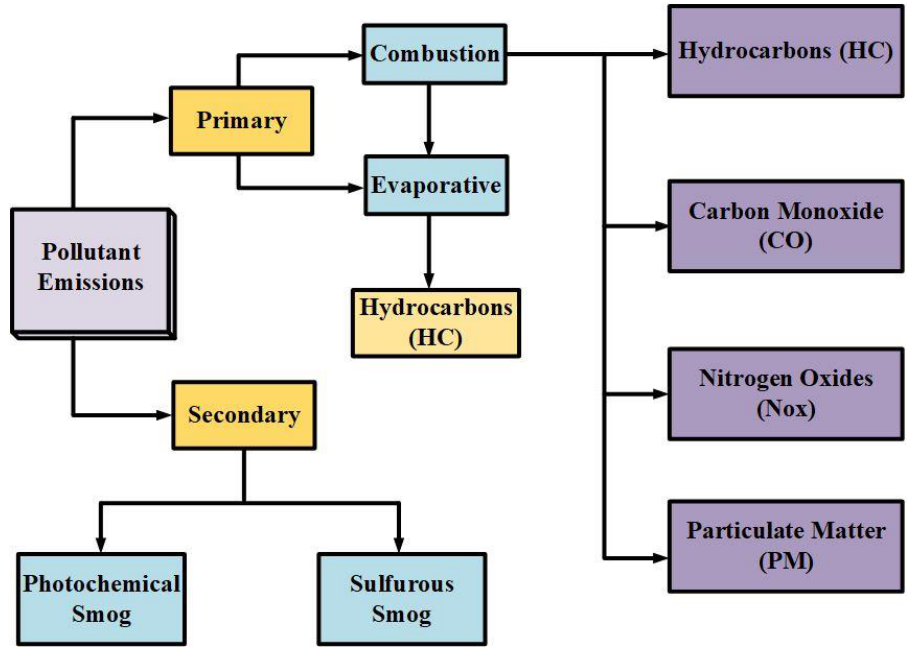
Figure 2. Types of pollutant emissions from vehicles with internal combustion engines.